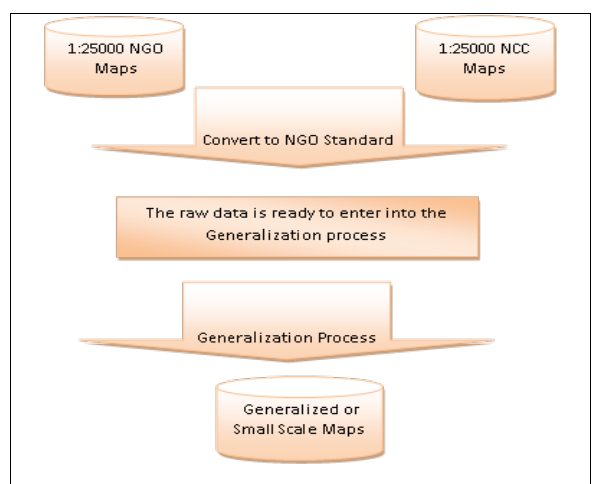
Figure 1. The Stages of base map standardization